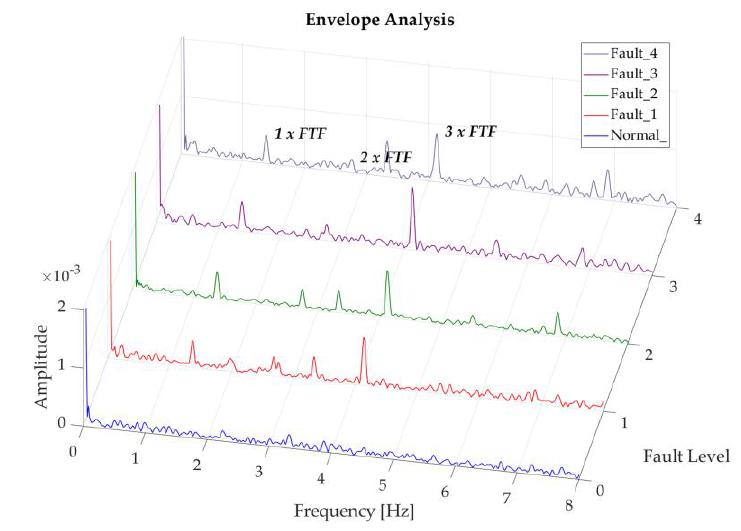
Figure 16. Representation of recordings of rolling element degradation at 200 rpm, analysis band of 9.8–12.8 × 10 3 Hz.